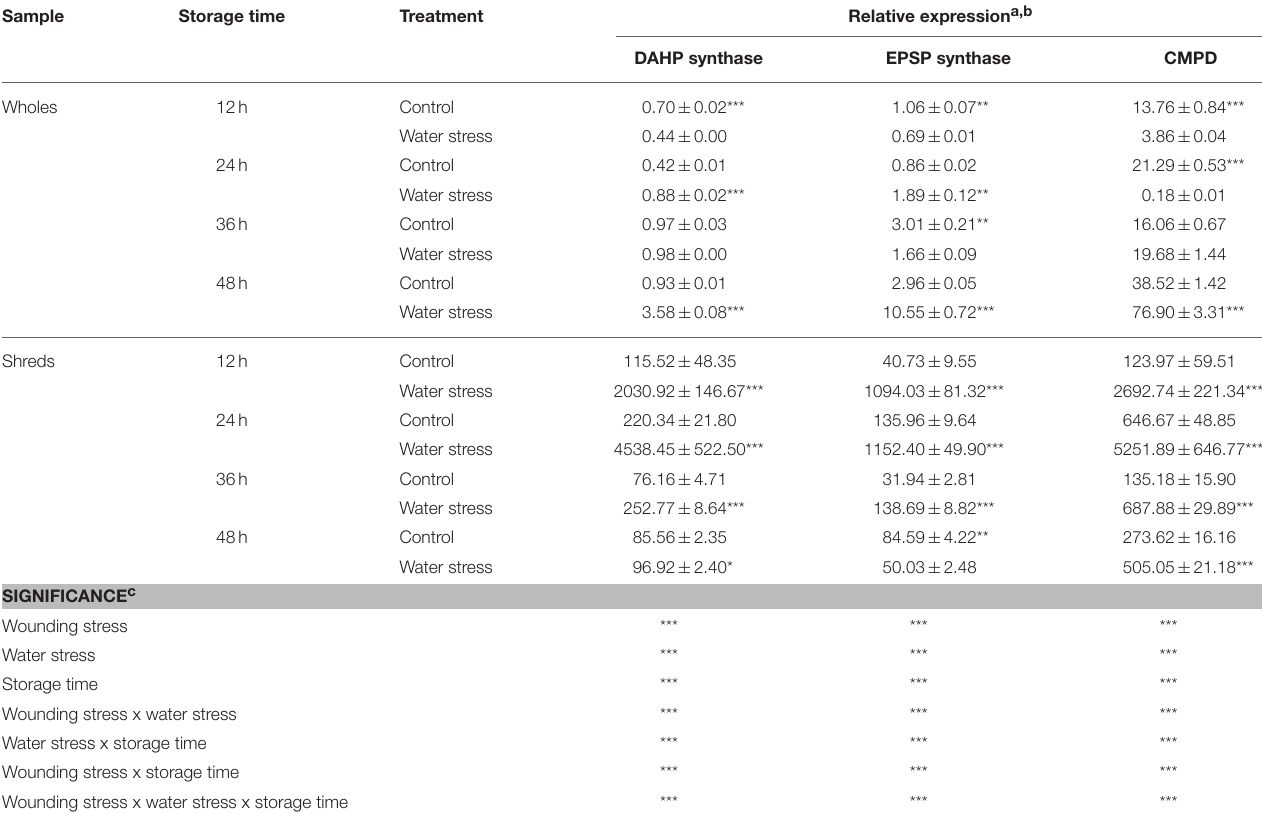
TABLE 1 | Relative expression of genes with putative function related with the primary metabolism in whole and shredded carrots stored for 48h under control and water stress conditions.